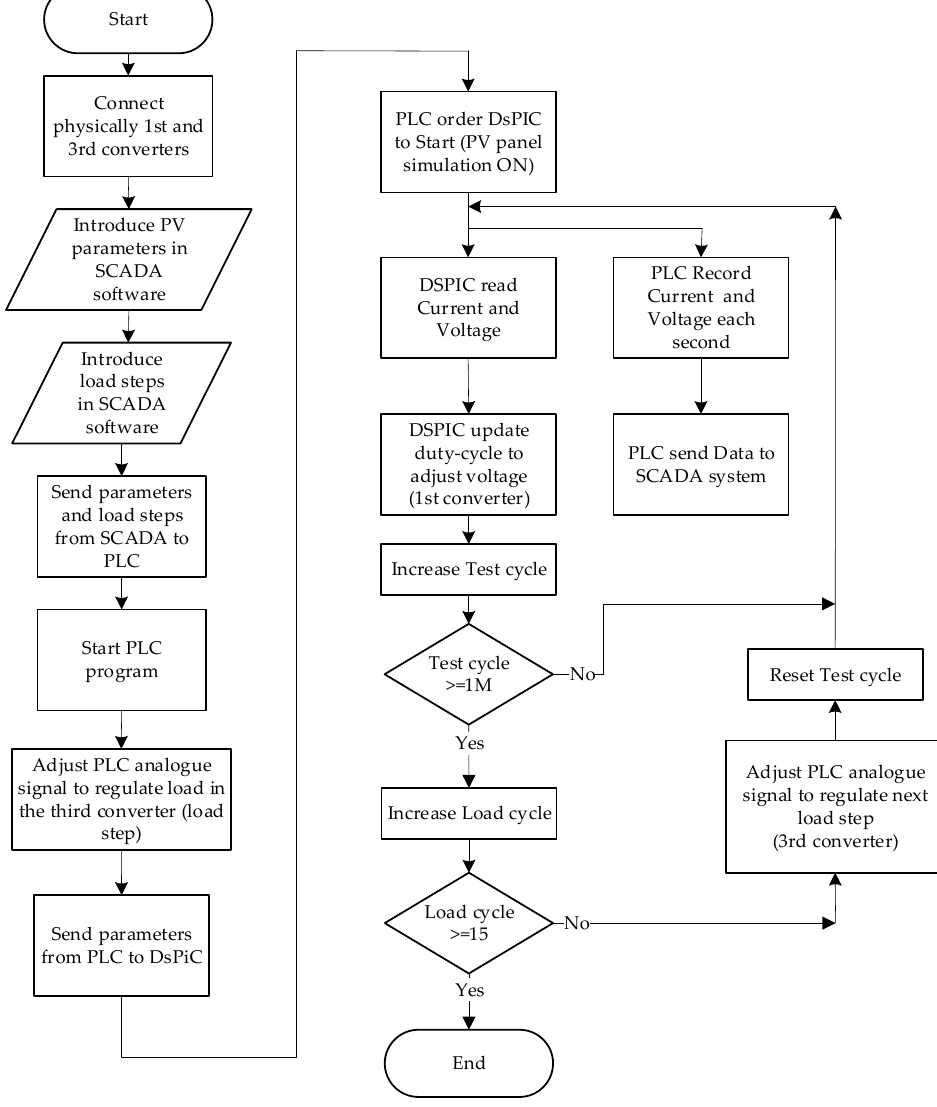
Figure 16. Flowchart of the automated test procedure applied to mode I.